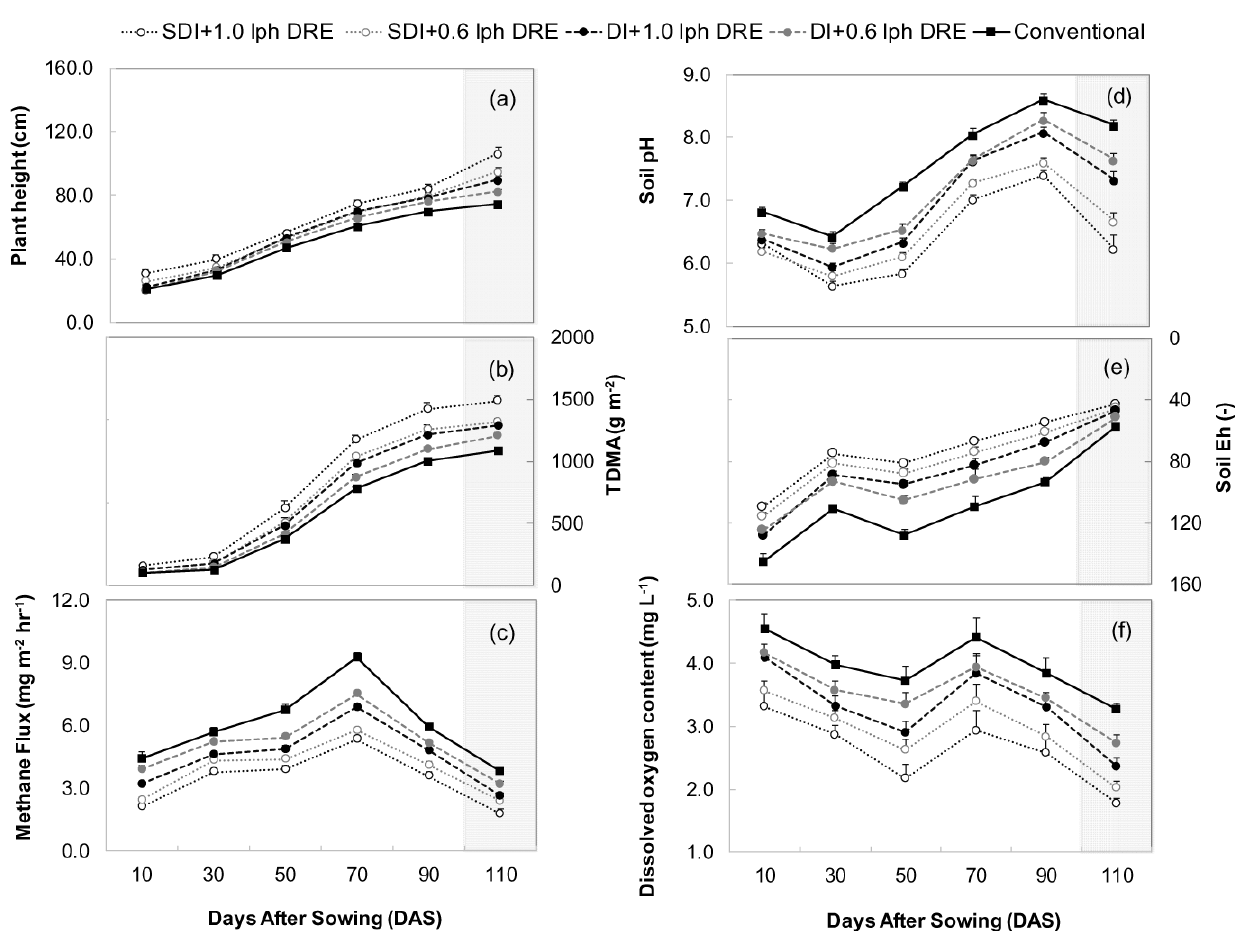
Figure 3. Effect of drip treatments on rice growth, change in methane flux, soil pH, soil Eh (redox potential) and dissolved oxygen content of drip-irrigated soil environment. Error bars indicate standard error of the mean (n = 6). Shading indicates the period after post-flowering phase (100 DAS). SDI, sub-surface drip irrigation; DI, surface drip irrigation; DRE, discharge rate emitters; Conventional, conventional flood aerobic